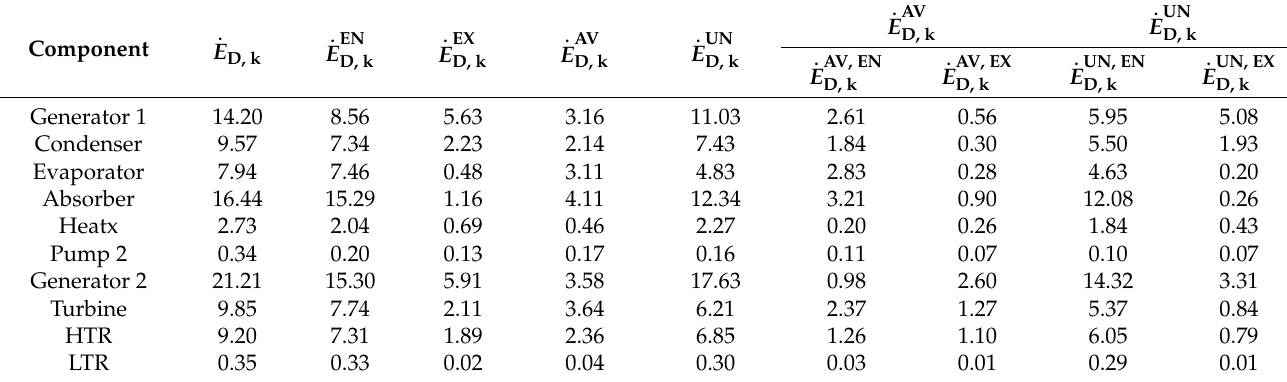
Table 4. Exergy destruction (kW) in each considered